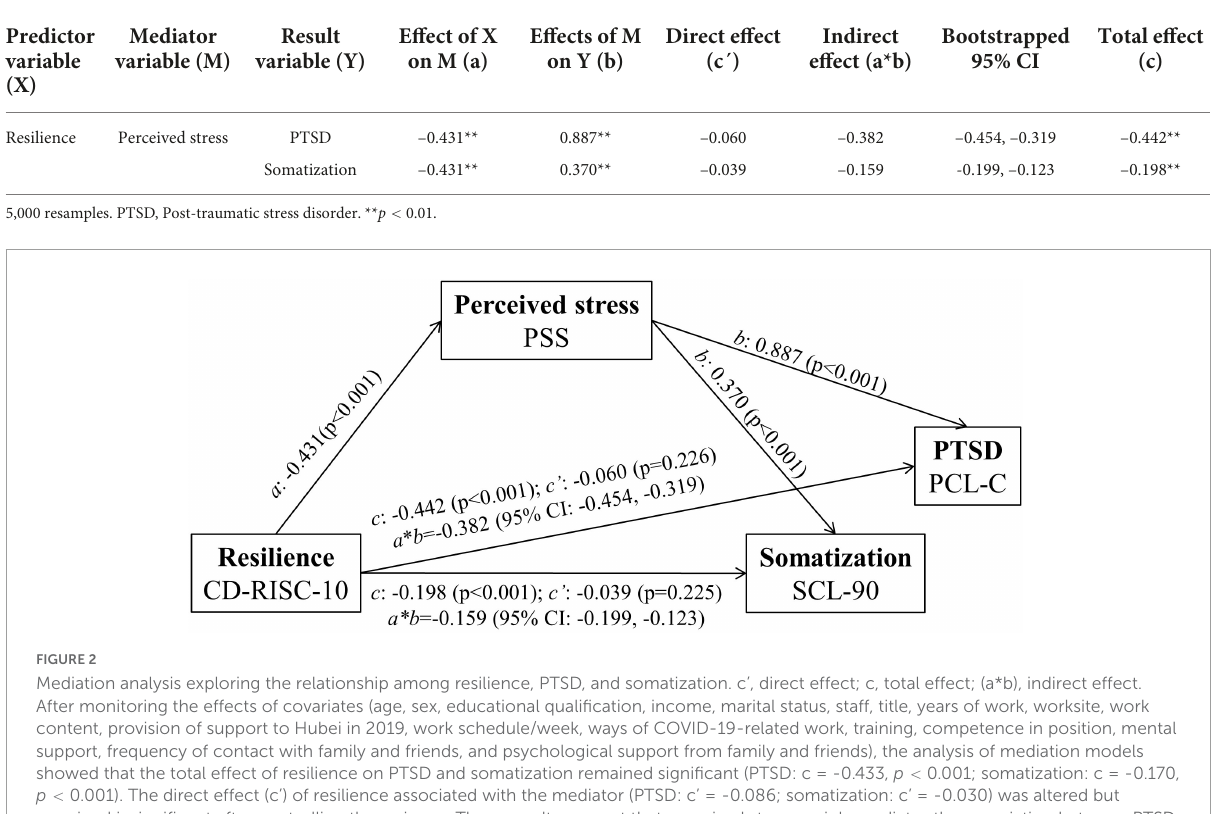
TABLE 5 Direct, indirect, and total effects of the mediator.